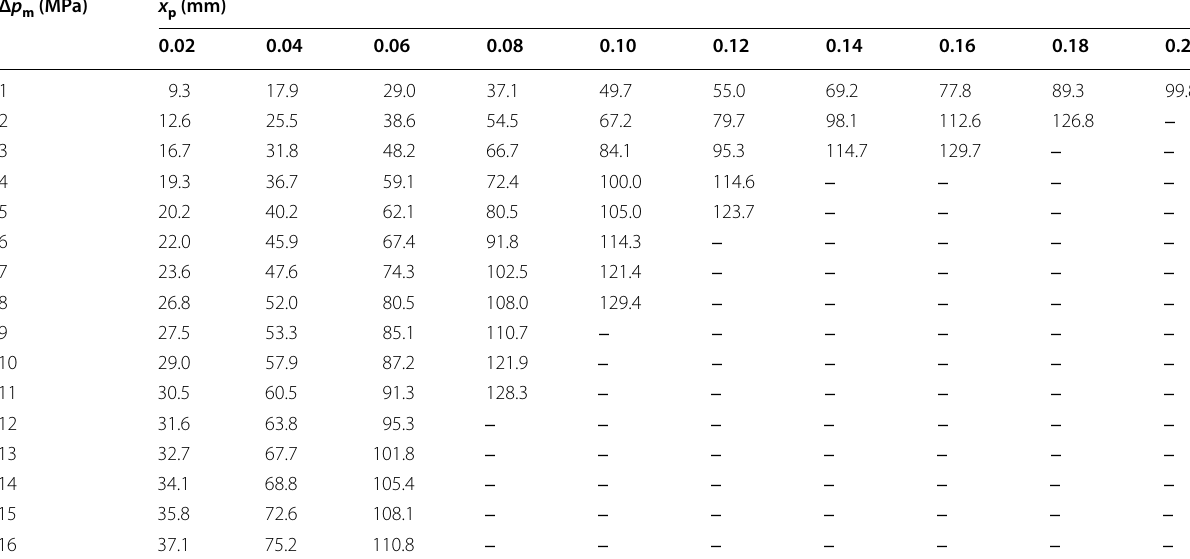
Table 3 Training data set for the inference of the flow through the Valvistor valve Δ p m (MPa)